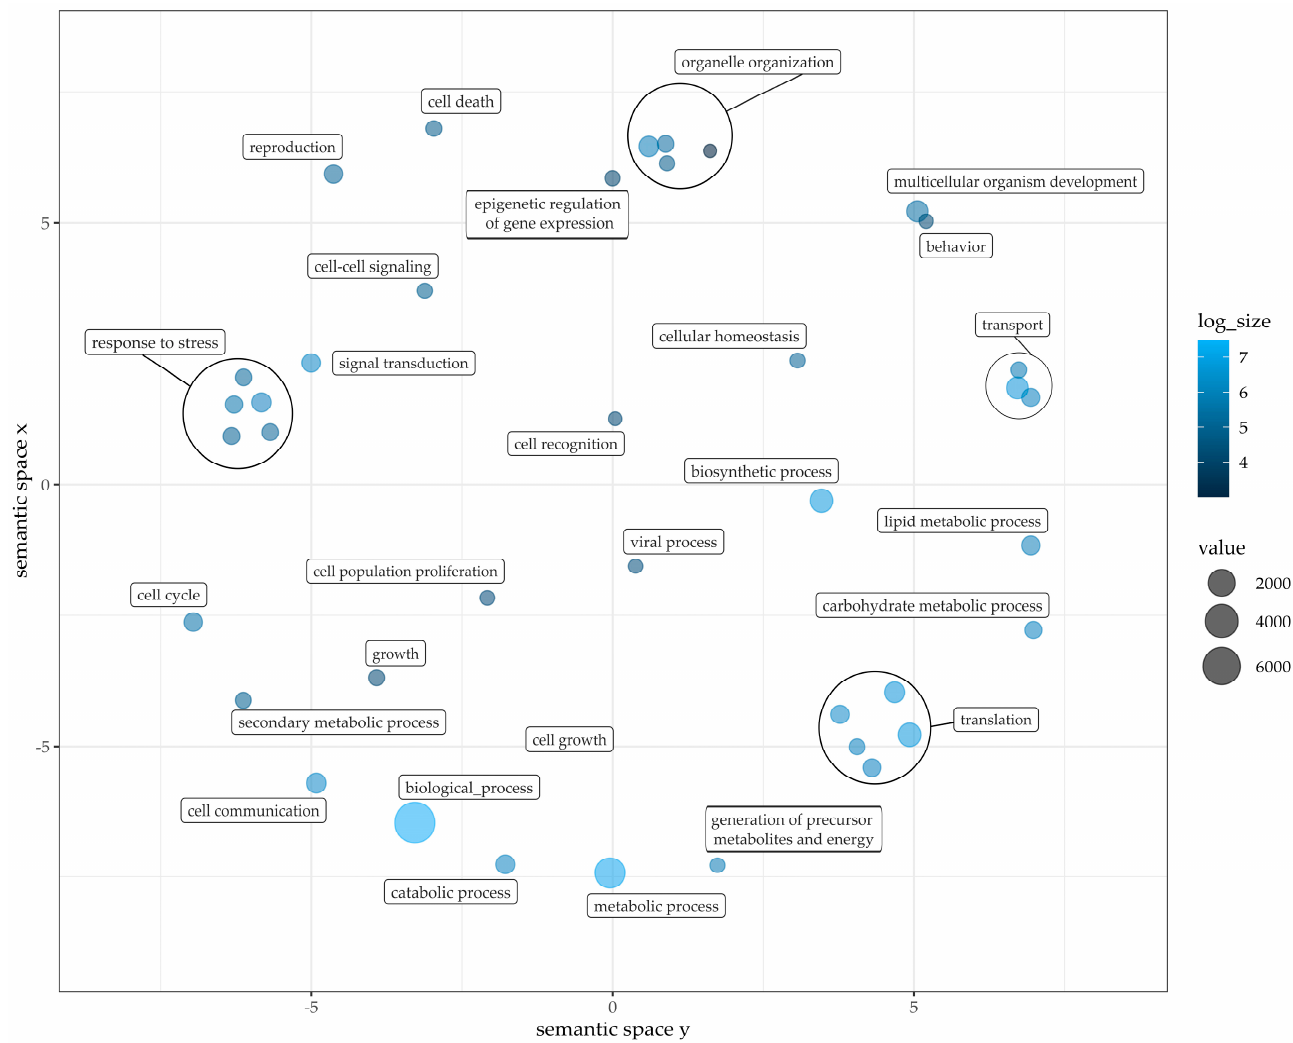
Figure 4. Gene Ontology term classification within biological processes of Pink Perfection. Clustered with response to stress: response to biotic stimulus, response to abiotic stimulus, response to external stimulus, response to endogenous stimulus. Clustered with translation: protein modification process, DNA metabolic process, nucleobase-containing compound metabolic process, protein metabolic process. Clustered with organelle organization: cytoskeleton organization, cytoplasm organization, mitochondrion organization. Clustered with transport: ion transport, protein transport. Figure was drafted employing REVIGO [59] and customized with R. Value and log size represents the counted GO terms across annotated gene